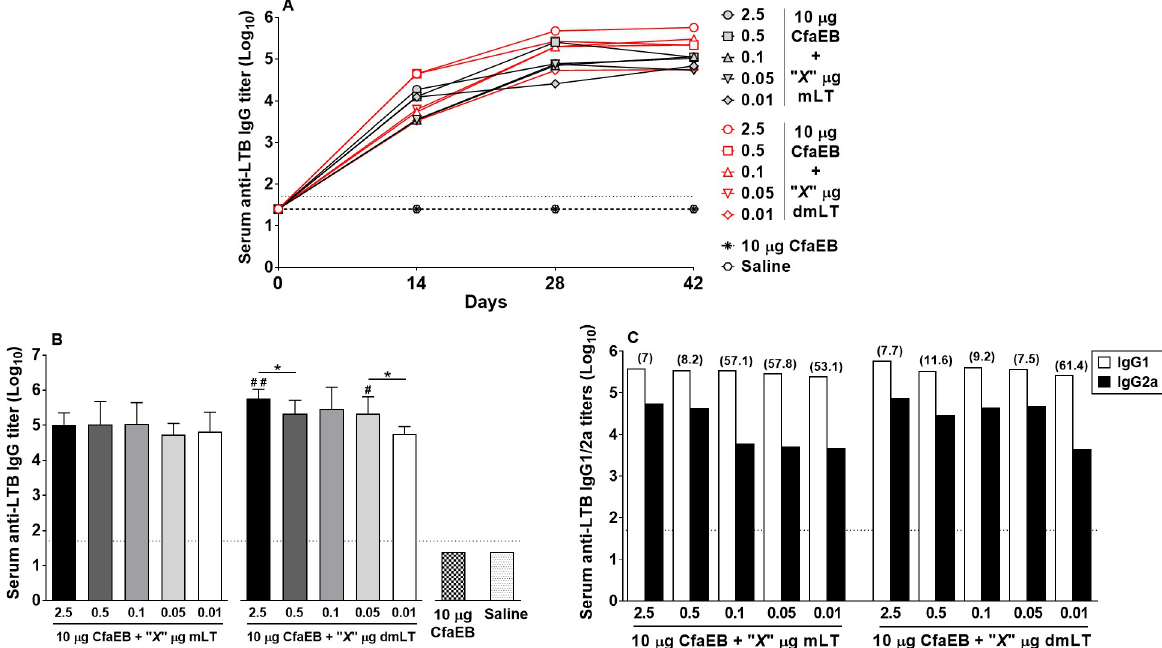
Fig 6. Serum anti-LTB IgG titers. (A) Kinetics of anti-LTB IgG Ab titers on d0 (evaluated with pool of 7 animals/group), d14 (evaluated with pool of 7 animals/group), d28 (evaluated with pool of 7 animals/group), and d42 (evaluated in individual sera, 5 animals/group); (B) Mean geometric log 10 transformed anti-LTB Ab IgG titers on d42 for all groups; (C) Anti-LTB IgG1 and IgG2a Ab titers on d42 performed with pooled sera (bars represent the mean of duplicate assays); IgG1/IgG2a ratios are shown in parentheses. Dotted horizontal line represents the limit of detection for the assay. � P < 0.05, �� P < 0.01, and ��� P < 0.001 indicated for statistical comparisons performed within mLT or dmLT groups; # P < 0.05, # # P < 0.01, and # # # P < 0.001 indicated for statistical comparisons performed between the same dose of mLT and